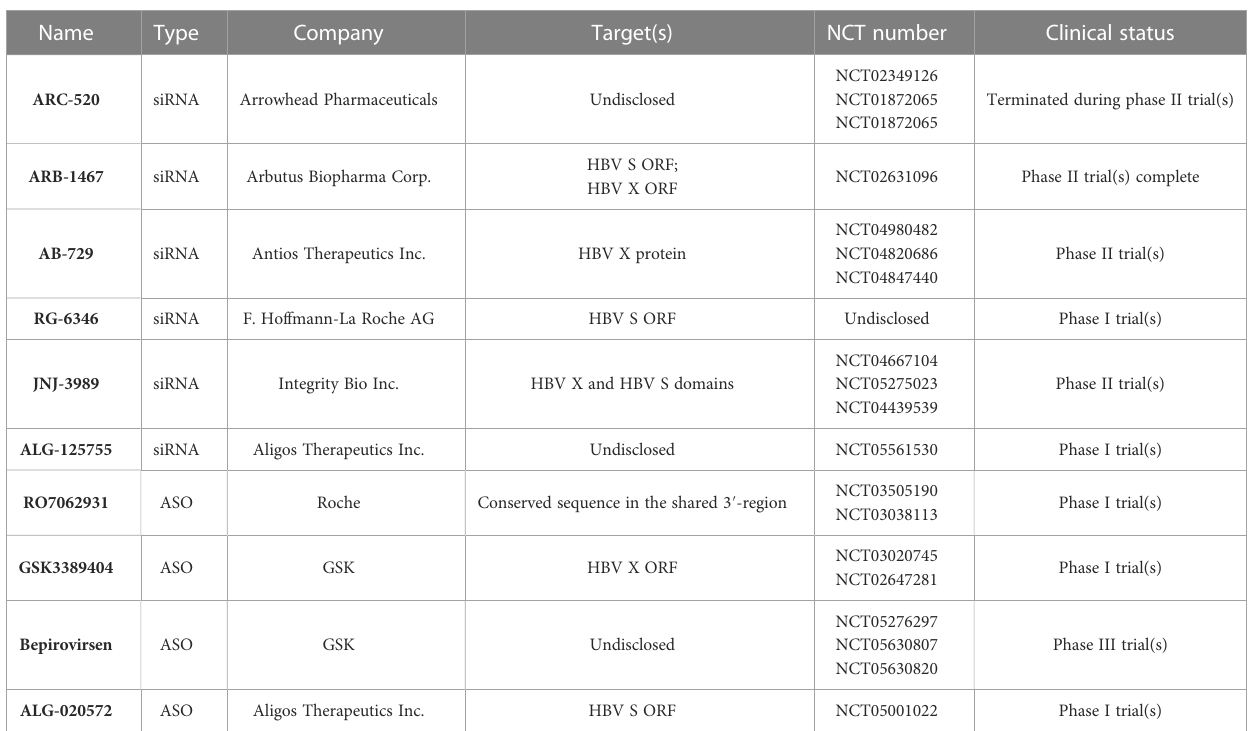
TABLE 3 Summary of molecules for RNA